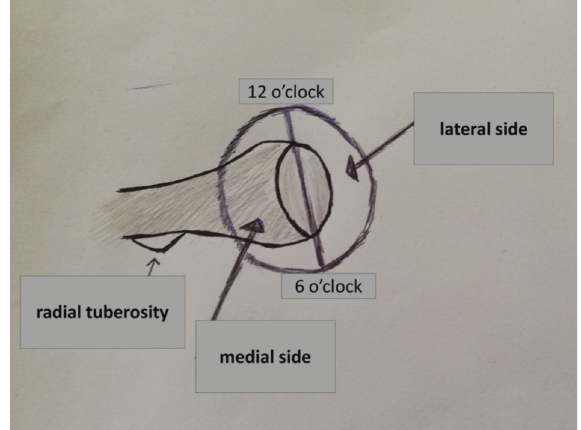
The radial tuberosity (6 o’clock) was used as a reference Fig. 1: point to distinguish fragments as lateral and medial ones (right